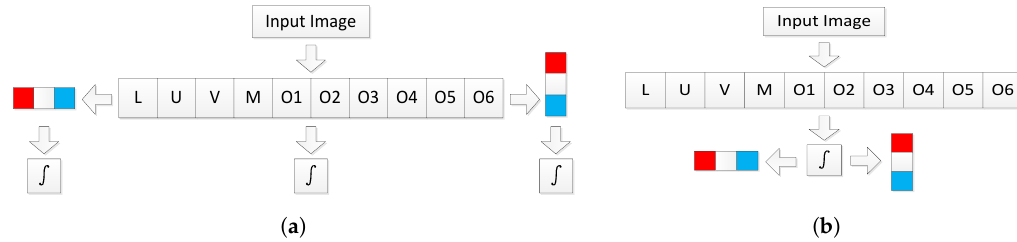
Figure 4. Acceleration strategy for computing integral maps. ( a ) Naive approach. Every feature maps need to be integrated; ( b ) Our method. Only the original 10 feature maps need to be